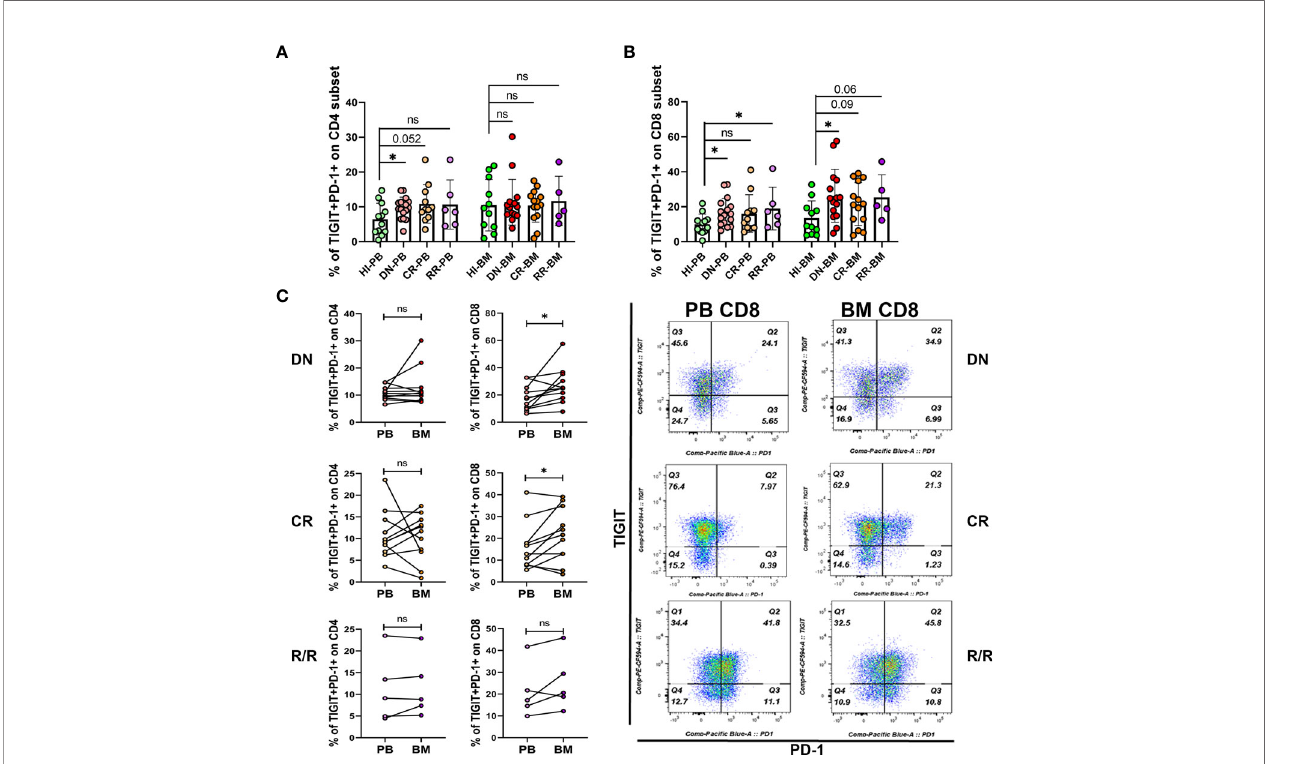
FIGURE 4 | Co-expression of PD-1 and TIGIT is increased in the PB and BM T cells of DN-AML patients. (A) Shown is the co-expression of PD-1 and TIGIT in PB and BM CD4 + T cells from HIs (PB, n=12; BM, n=11) and patients in the DN-AML (PB, n=16; BM, n=15), CR-AML (PB, n=11; BM, n=14), and R/R-AML (n=5) cohorts. (B) Co-expression of PD-1 and TIGIT in PB and BM CD8 + T cells from HIs and patients in the DN-AML, CR-AML, and R/R-AML cohorts. The cases in the fi gure are the same as those in the CD4 + population. The p values in (A, B) were calculated by the independent student ’ s t-test. (C) Comparison of PD-1 and TIGIT co-expression between the paired PB and BM CD4 + and CD8 + subsets. Higher co-expression existed in the BM CD8 + T cell from most of the DN-AML and CR- AML patients. The p values shown in C were calculated by the paired student ’ s t-test. * p < 0.05, ns denotes not signi fi